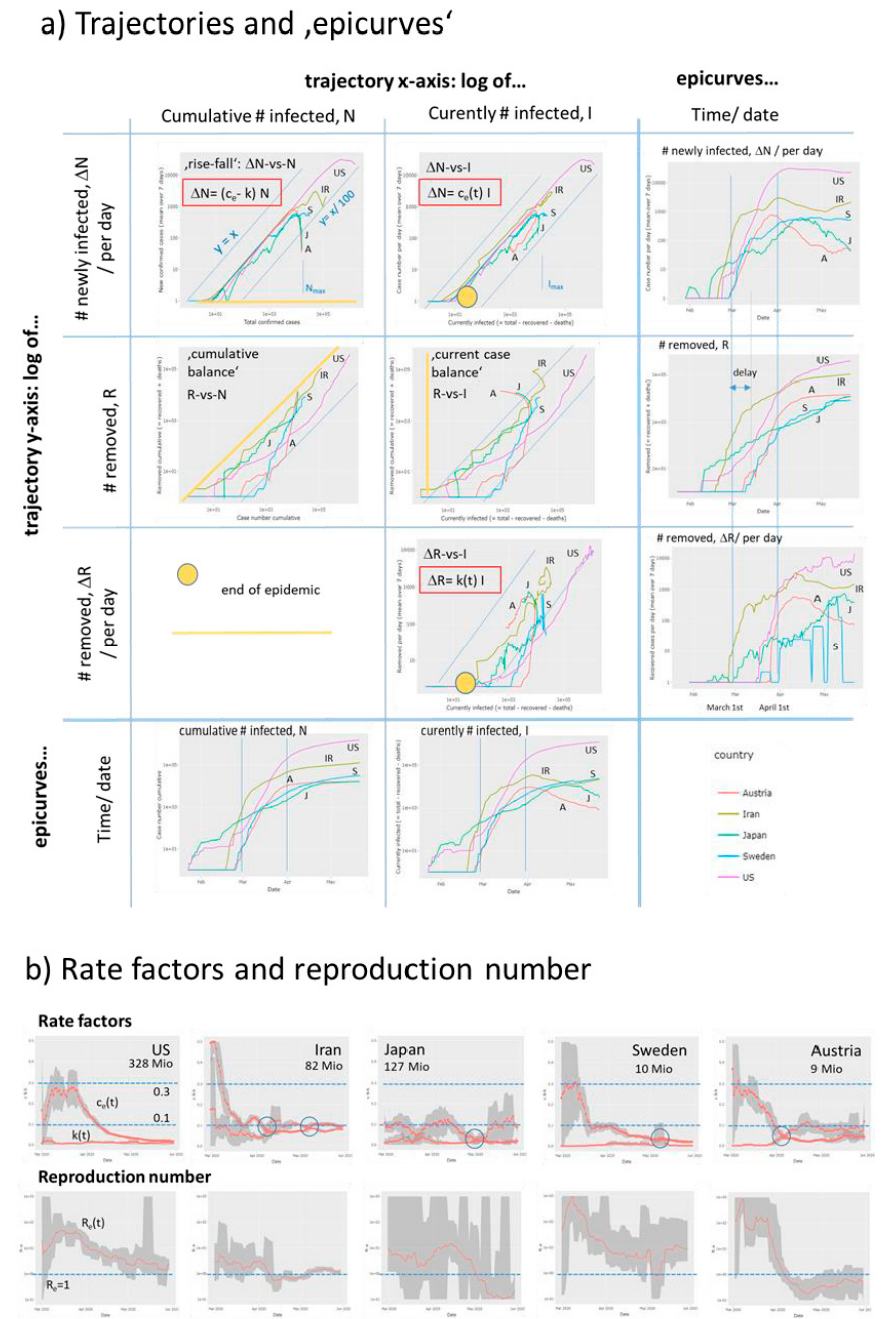
Figure 5. Dynamic Covid-19 characteristics of selected countries. ( a ) Trajectories and the respective time dependencies (‘epicurves’) plot different numbers as indicated in the figure. The yellow marks (circle and lines) indicate the ‘end’ points where the trajectories are expected to return upon eradication. See also Supplementary File for details. ( b ) Rate factors of transmission and the respective reproduction numbers as a function of data.